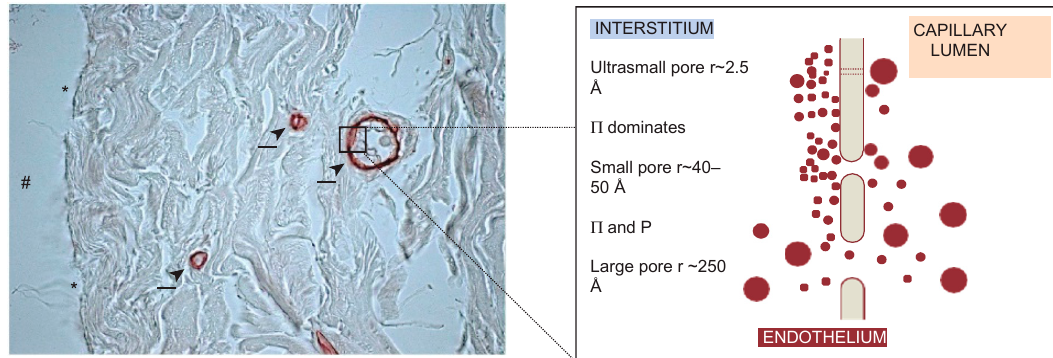
Figure 2. Microscopic structure of the peritoneal membrane and the three-pore model (TPM). ( Figure 2 is reproduced from [59] with permission). To the left : Micrograph of the cross-section of the human parietal peritoneum stained for the water channel aquaporin-1 (AQP1). The peritoneal membrane contains three components: a layer of ciliated mesothelial cells (*), with microvilli and apical protrusions into the peritoneal cavity (#); the interstitial tissue consisting of bundles of collagen and mucopolysaccharides; and a dense network of capillaries, blood vessels, and lymphatics. During peritoneal dialysis (PD), the microvascular endothelium (arrows, stained in red) represents a functional barrier for the transport of solutes and water from the blood of the patient to the dialysate that has been instilled in the peritoneal cavity. To the right: (inset) The endothelium lining the peritoneal capillaries can be functionally described within the three-pore model (TPM). The small pores (radius ~ 40–50 Å), located between the endothelial cells, account for ~90% of the peritoneal ultrafiltration coefficient and 99.5% of the total pore area available for solute transport. The large pores (radius ~ 250 Å), thought to correspond to interendothelial gaps occupying <0.5% of the total pore area. The ultrasmall pores (radius ~ 2.5 Å) are the only ones to be located in the endothelial cells. (Caption to the Figure 2 is adapted from [59] with permission).